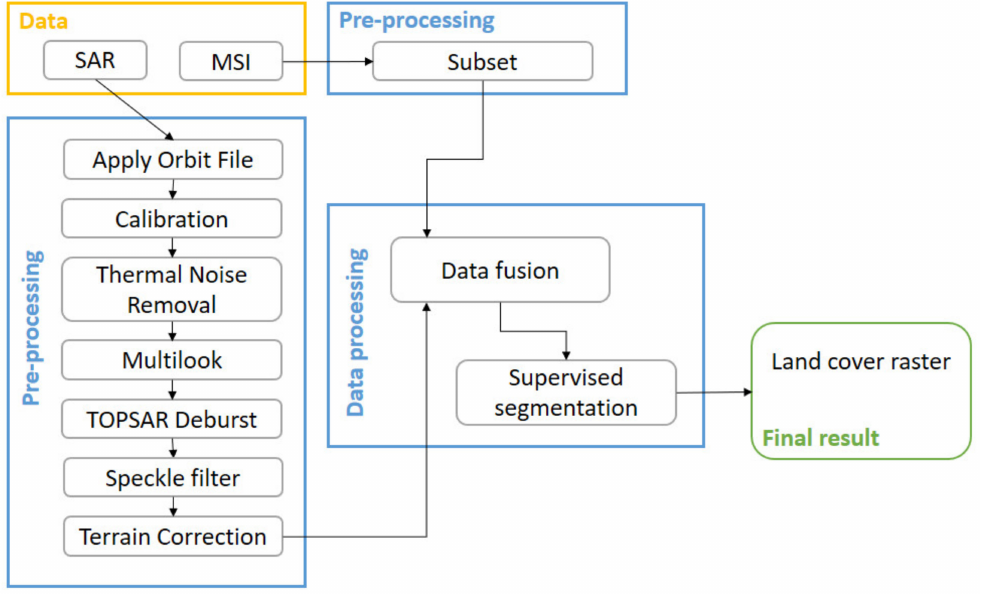
Figure 8. Processing schema of SAR and MSI data